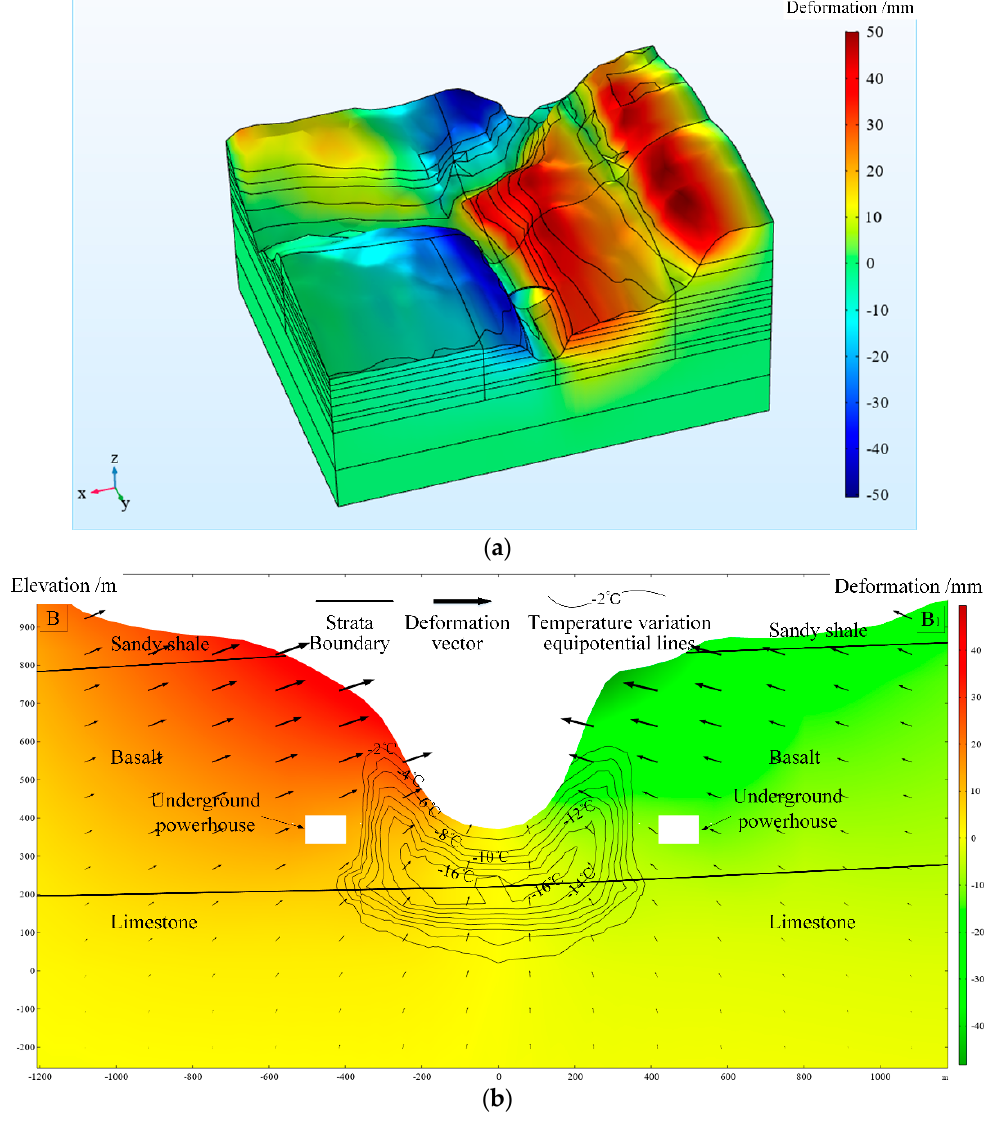
Figure 18. Deformation patterns: ( a ) 3D overview; ( b ) B–B1 section in Figure 13.